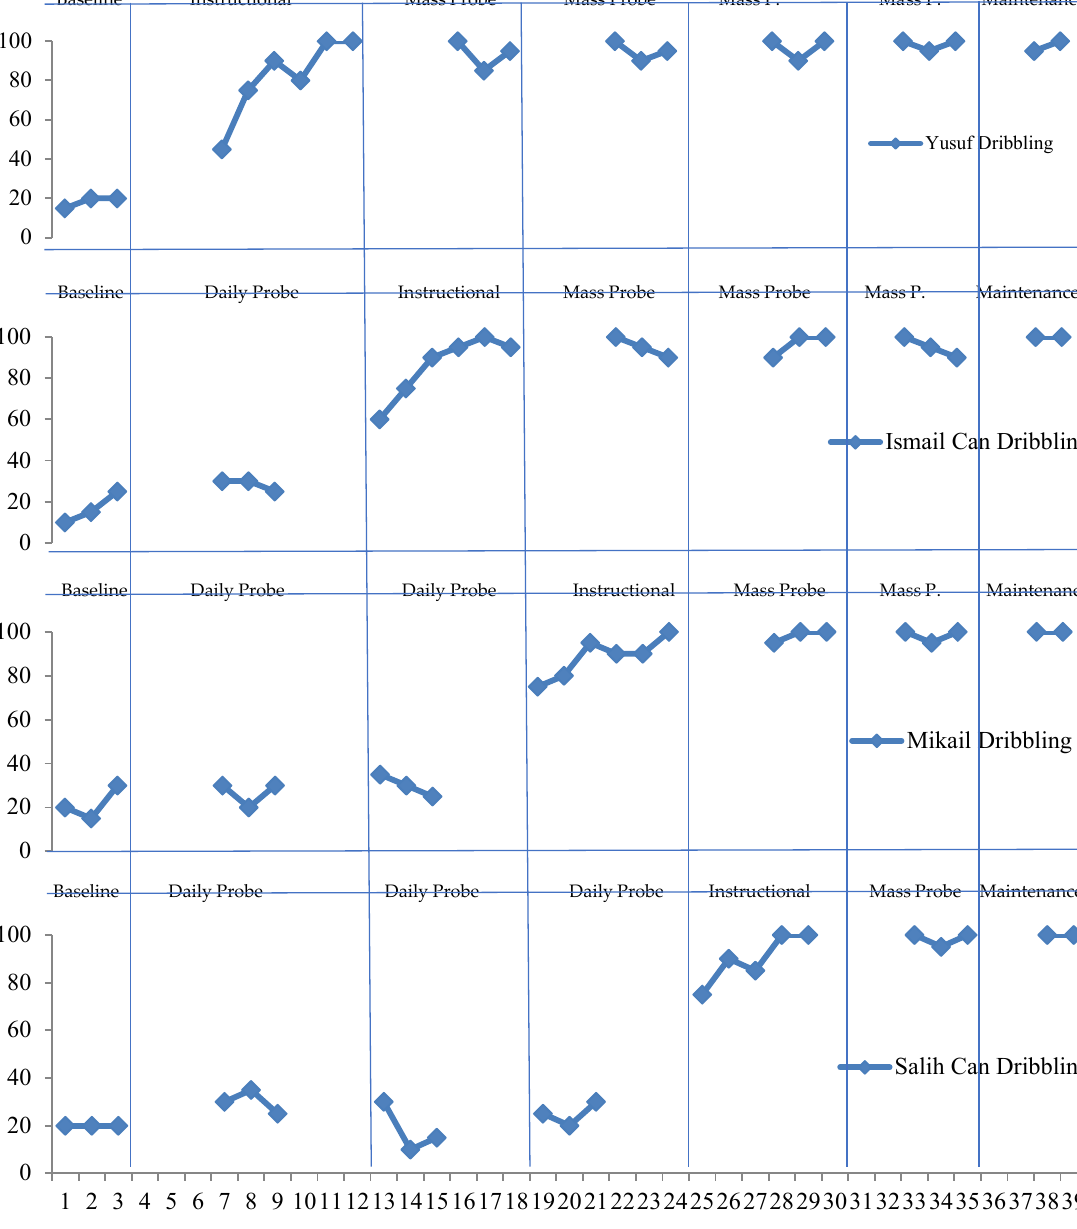
Figure 3. Data on the instructional of dribbling skills in basketball.